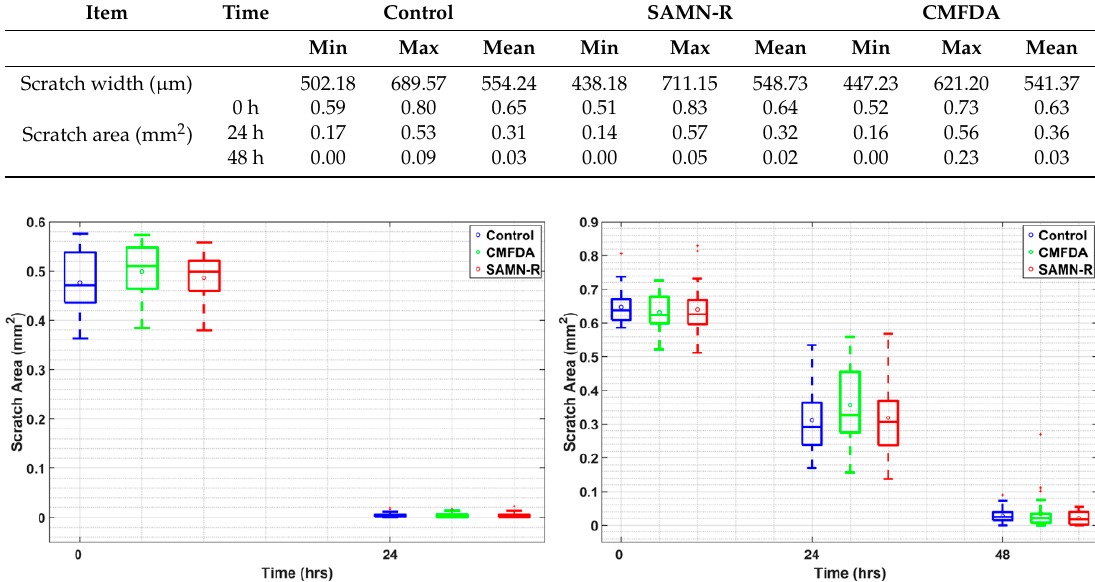
Figure 7. Time-dependent changes in the size of the open area due to 3T3 cell migration ( left ) in narrow scratch and ( right ) in wide scratch. Each box represents scratch areas in 30 images in each group. Each box plots the 25th and 75th percentiles. The circle inside the box is the mean, the band inside the box is the median. Whiskers (the most extreme values not considered as outliers) and outliers (red squares) are outside the box.